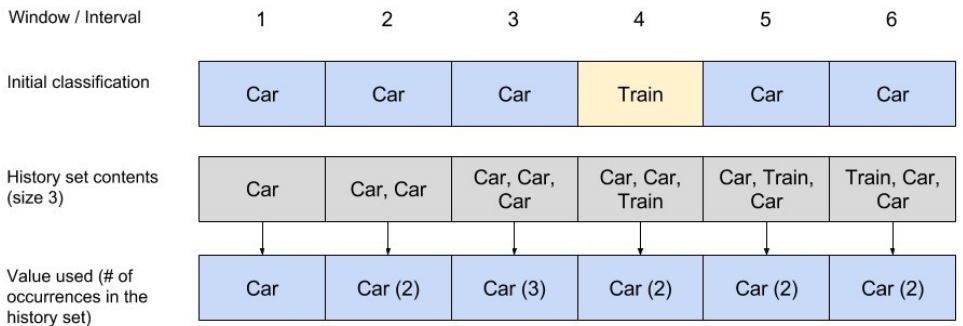
Figure 3. How the historical set can remove noise. It is improbable for a transportation mode to switch for only 5 s (1 interval window). switch for only 5 s (1 interval window).